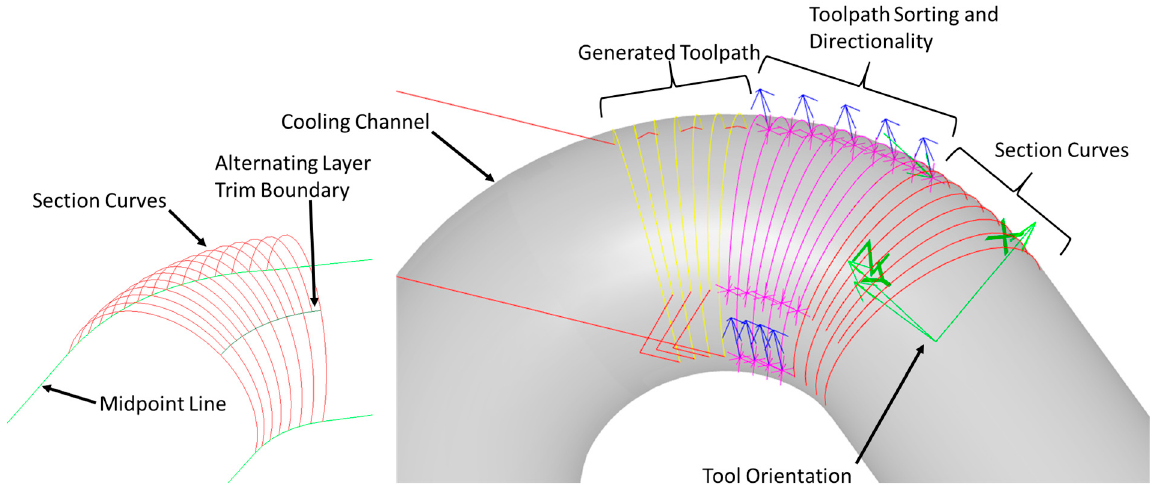
Figure 3. Curved cooling channel CAM strategy (refer to Video S3); ( left ): isoparametric section curves of the top half of a conformal cooling channel; ( right ): three sections of the conformal cooling channel CAM strategy at various stages.